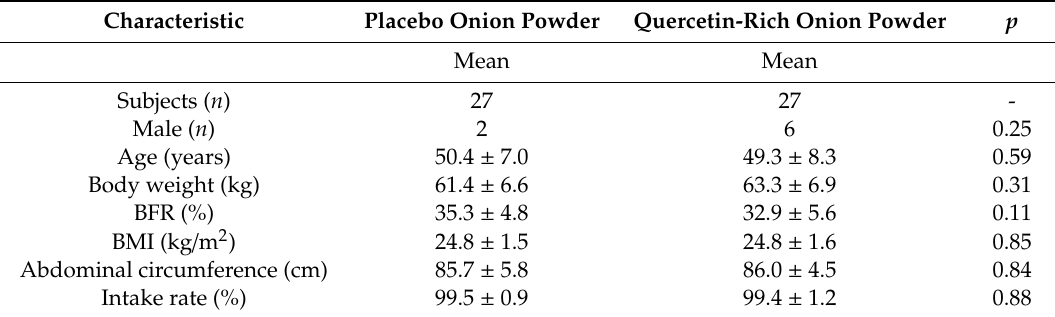
Table 4. Baseline of subjects and intake rates of test foods in the quercetin-rich onion and placebo groups.